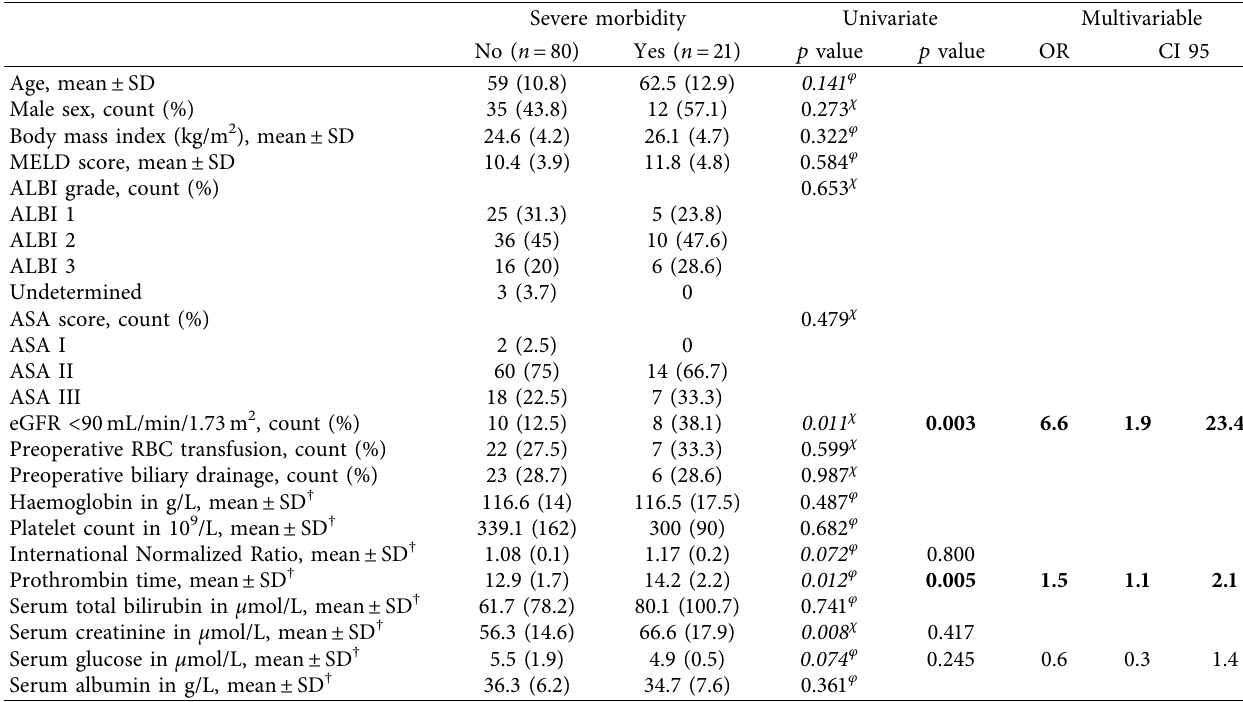
Table 4: Univariate and multivariable analysis for prediction of 90-day severe morbidity (Clavien–Dindo ≥ IIIb) after pancreaticoduodenectomy for ampullary